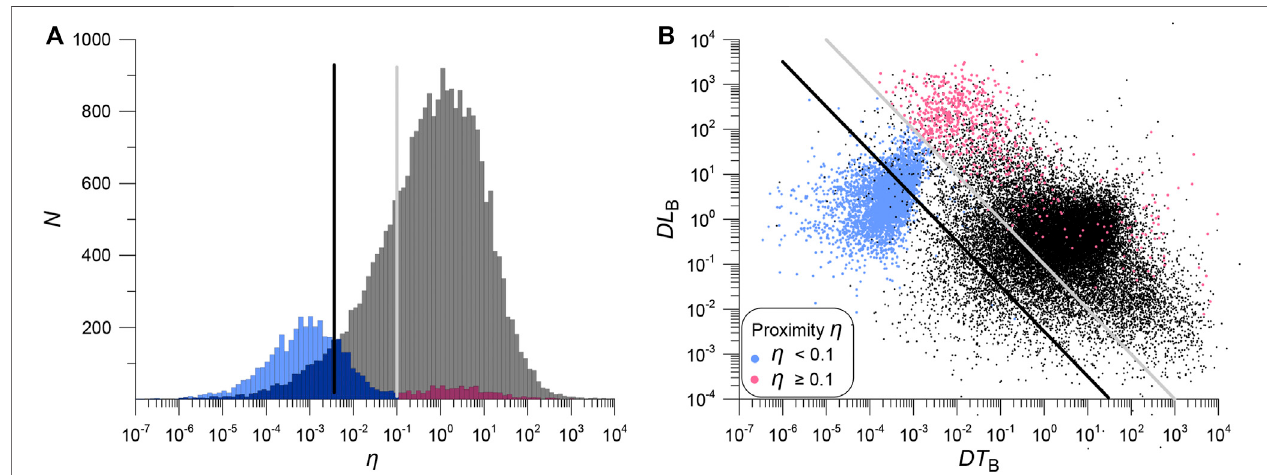
FIGURE 9 | Distribution and space-time structure of duplicates and aftershocks for the proximity function η (Eq. 1) , parameters as in Shebalin et al. (2020). (A) Distributionofproximityfunction η forduplicates(colored histogram) and aftershocks (grayhistogram).The black and gray lines show possible thresholdsforseparating duplicates.Thegraylinecorrespondstotheminimumdistribution forduplicates, theblacklinecorrespondstoanequalnumber oferrorsofthe fi rstandsecondkind. (B) Distributionofduplicates(coloreddots)andaftershocks(blackdots)inspaceandtime.Thegrayandblacklinesshowtheproximityfunction (Eq.1) levellines(same asinpanel (A) ). DT B (cid:2) DT · 10 − bM /2 ,and DL B (cid:2) DL d f · 10 − bM /2 , d f isthefractaldimension oftheepicenterdistributionand b theslopeoftheearthquake-sizedistribution.